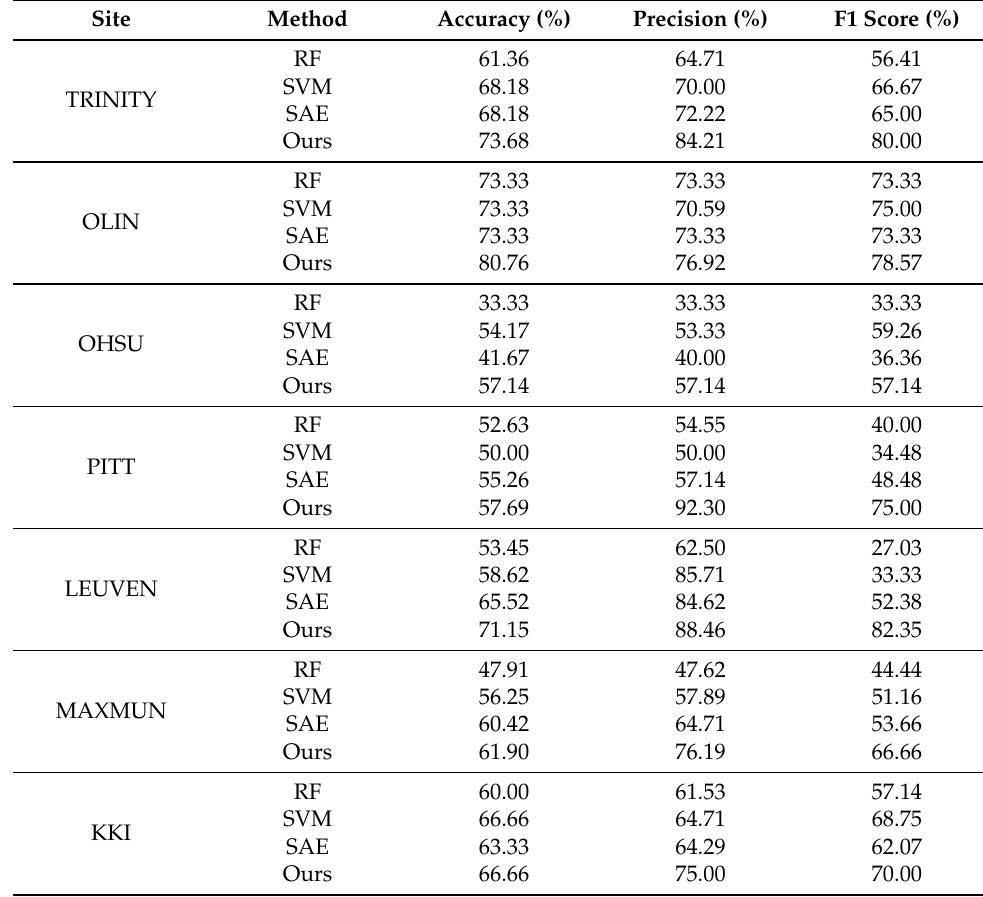
Table 3. Performance comparisons between the proposed model and competing